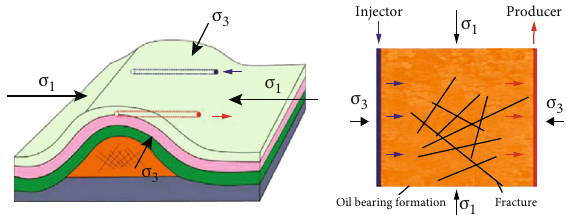
Figure 1: A sketch map of the fl ow in a fractured reservoir with in situ stress